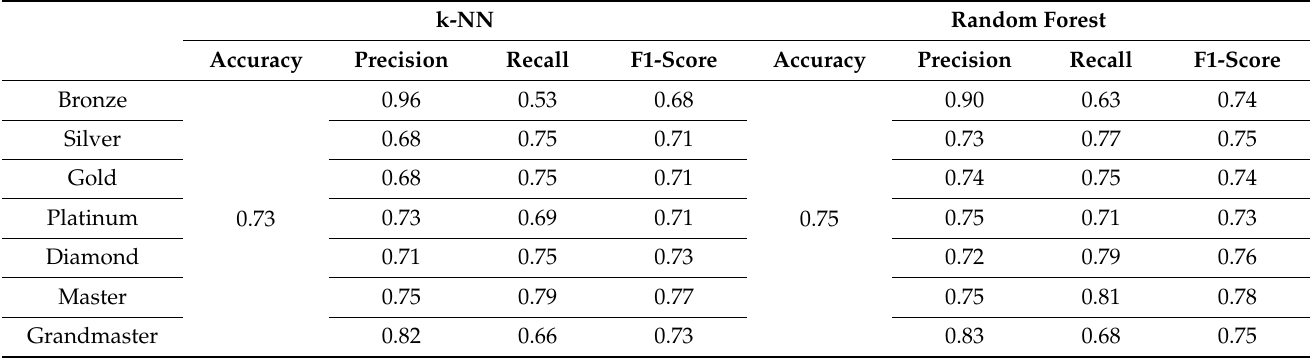
Table 5. Comparison of two algorithms. Random Forest performed better than k-NN. k-NN Random